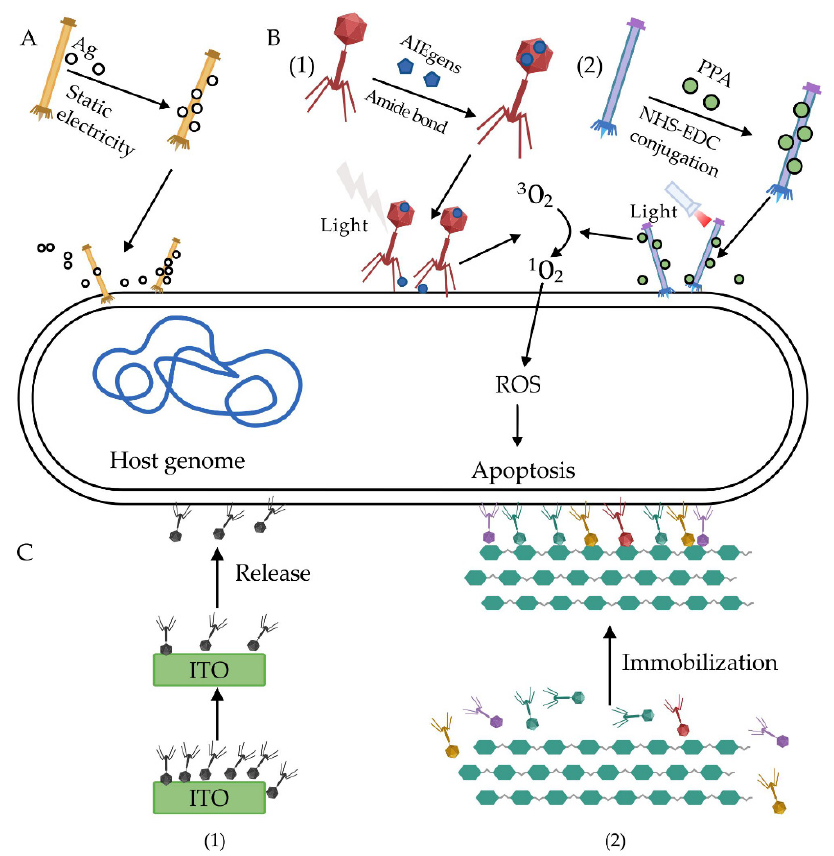
Figure 3. A phage chemical modification strategy against multidrug-resistant (MDR) bacteria. ( A )